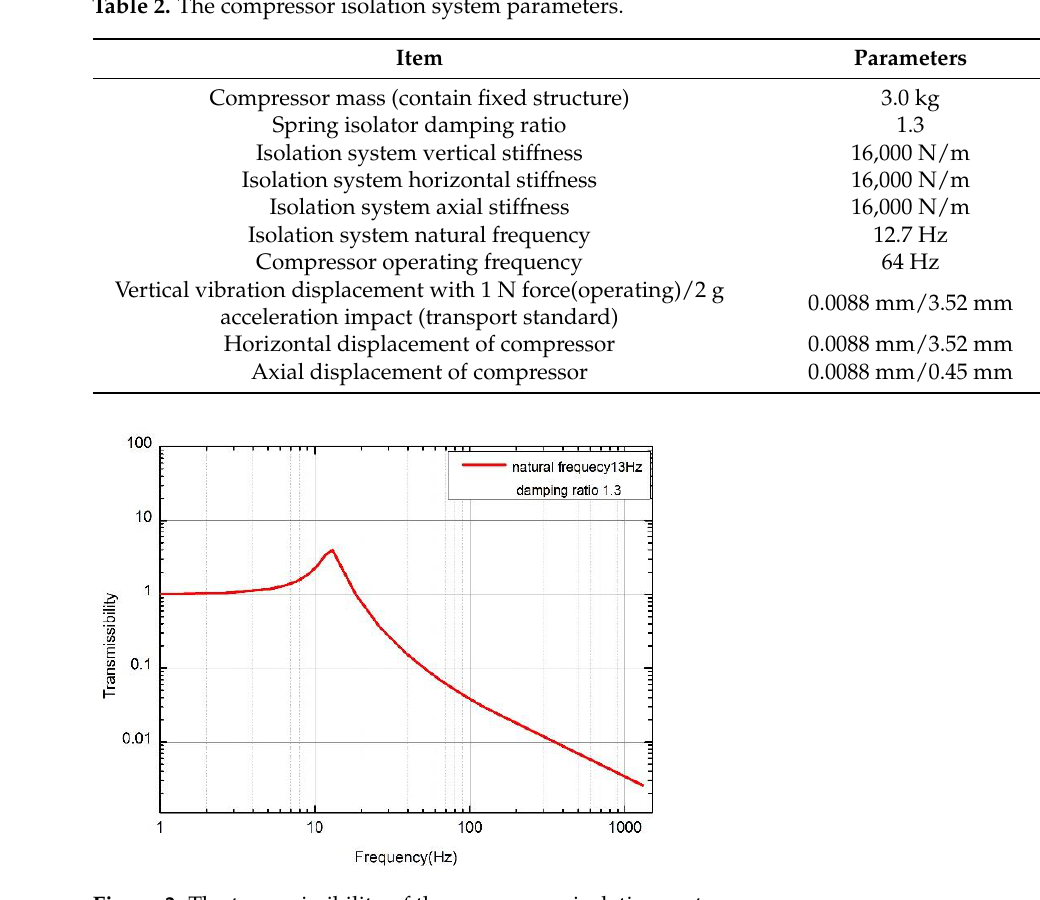
Figure 3. The transmissibility of the compressor isolation system.